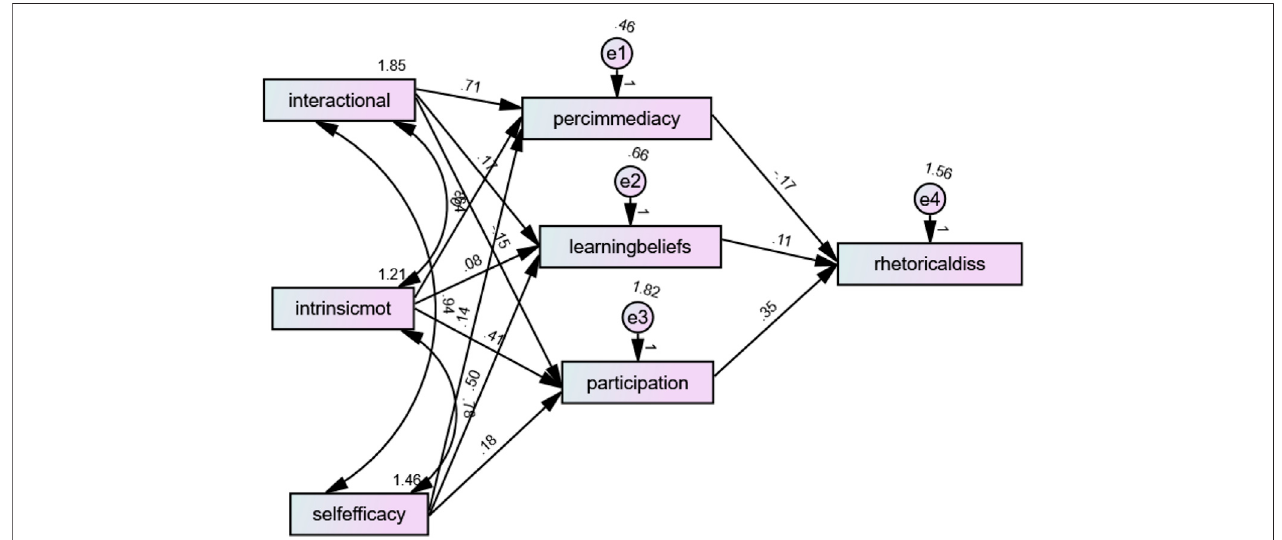
FIGURE 4 | Rhetorical dissent with class preference (Supported